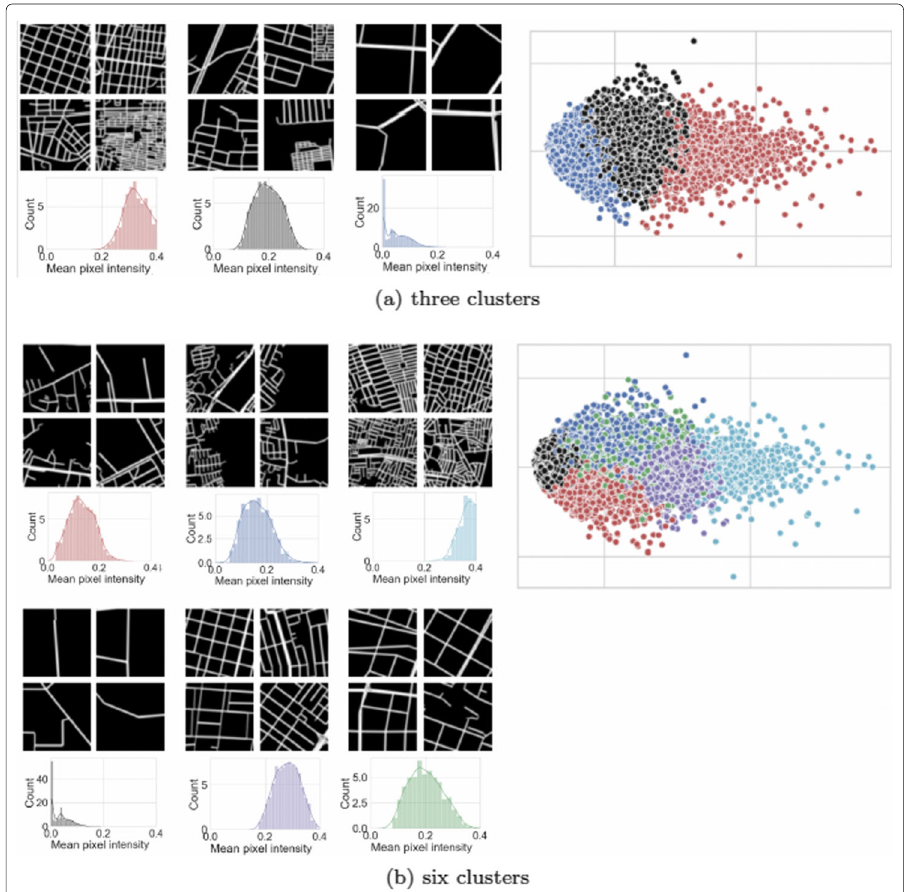
Fig. 6 a Three or b six clusters of urban street forms obtained by applying K-meansalgorithm to the condensed urban network vectors. Subfigures show example street networks in each cluster (top left), street network density in each cluster (bottom left) approximated using pixel intensity of street images, and a two-dimensional visualisation of all urban vectors with colour-coded cluster membership